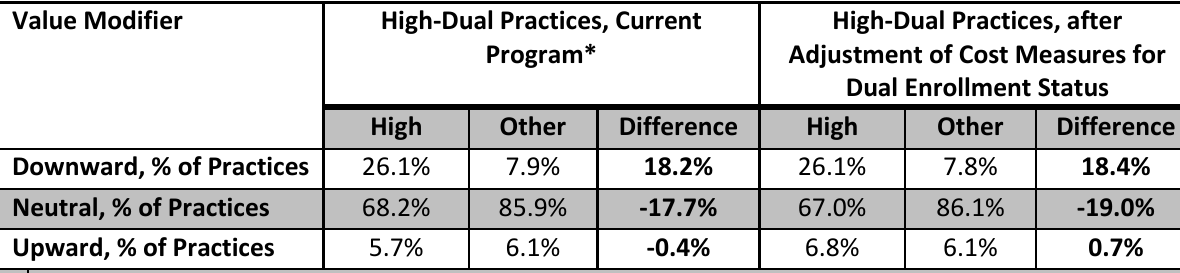
Table 10.20. Impact of Adjusting Mandatory Cost Measures for Dual Enrollment Status Value Modifier High-Dual Practices, Current High-Dual Practices, after Program* Adjustment of Cost Measures for Dual Enrollment Status High Other Difference High Other Difference Downward, % of